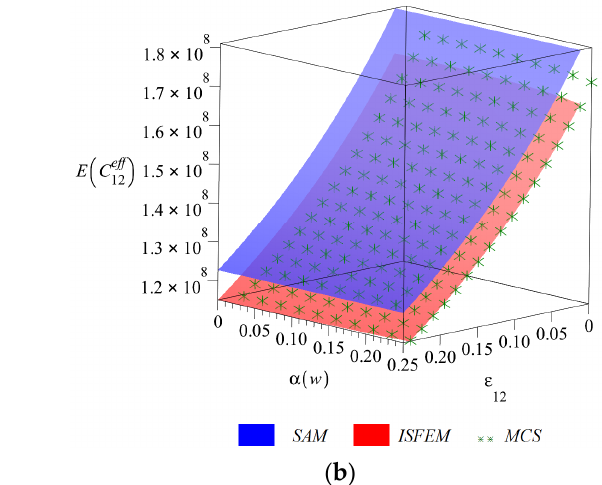
Figure 2. Principal strain isosurfaces for the ( a ) uniaxial and ( b ) biaxial tension, as well as ( c ) shear of the